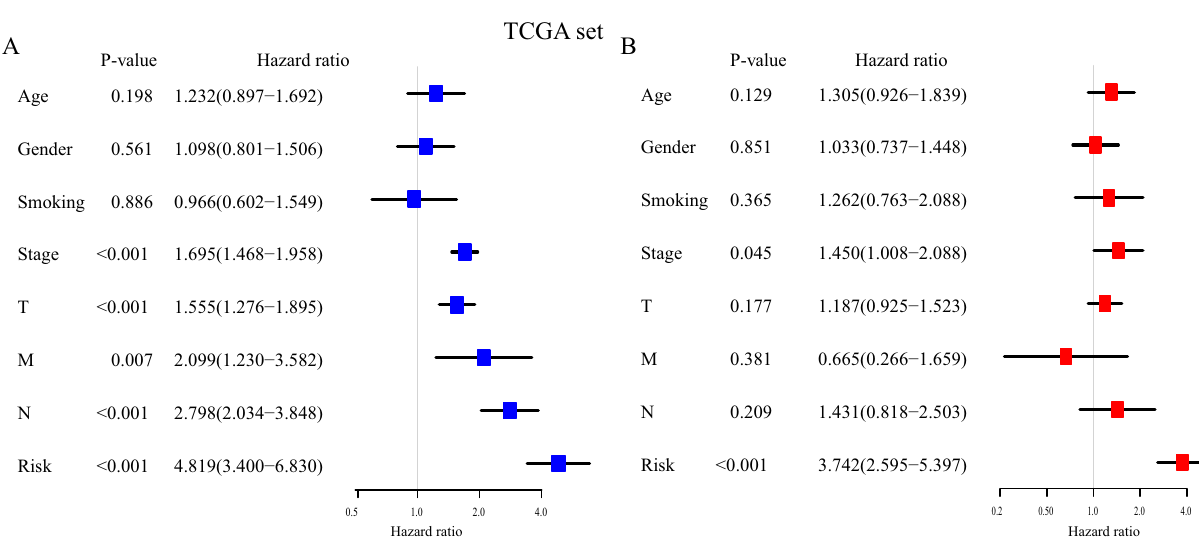
Figure 5. The IRGPs signature is an independent prognostic factor for the prognosis of LUAD patients. ( A ) The result of univariable Cox regression analysis in the TCGA set. ( B ) The result of multivariable Cox regression analysis in the TCGA